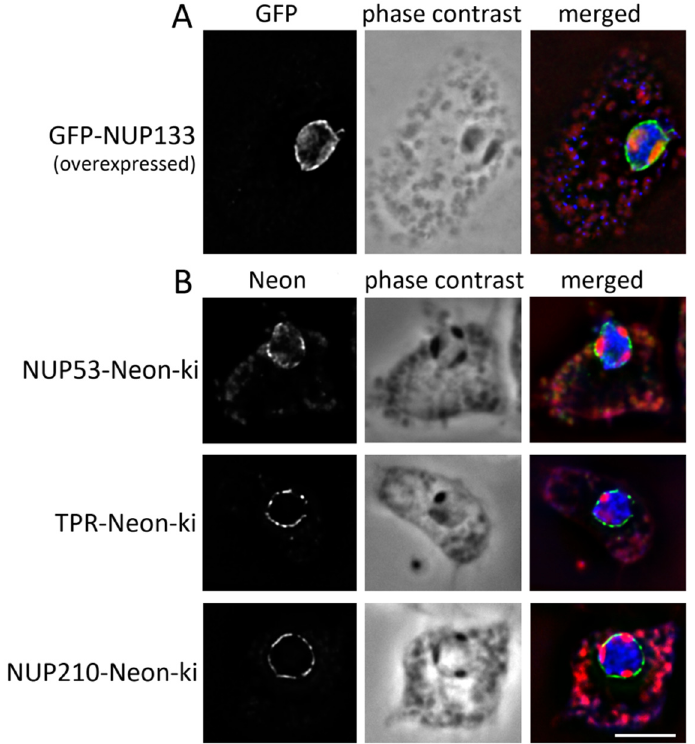
Figure 2. NUPs are absent from the contact sites of the nucleoli with the nuclear envelope. Wide field fluorescence microscopy of glutaraldehyde fixed GFP-NUP133 ( A ) or NUP-Neon-fusion protein ( B ) expressing cells in interphase. Nucleoli are visualized with phase contrast and can be seen as dark areas inside of the nucleus. Overlay (right) of the green fluorescent protein signal (green) with phase contrast (red) and DAPI (blue). Only one Z-slice is shown. Z-stacks are provided as Videos S1–S4. Bar = 5 μ m.